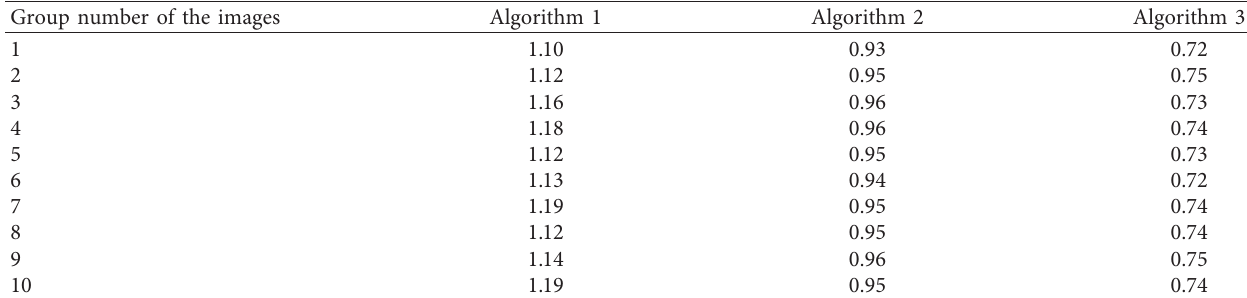
Figure 8: Relationship between the changes in the contrast and the matching probability. Table 1: Comparison of recognition